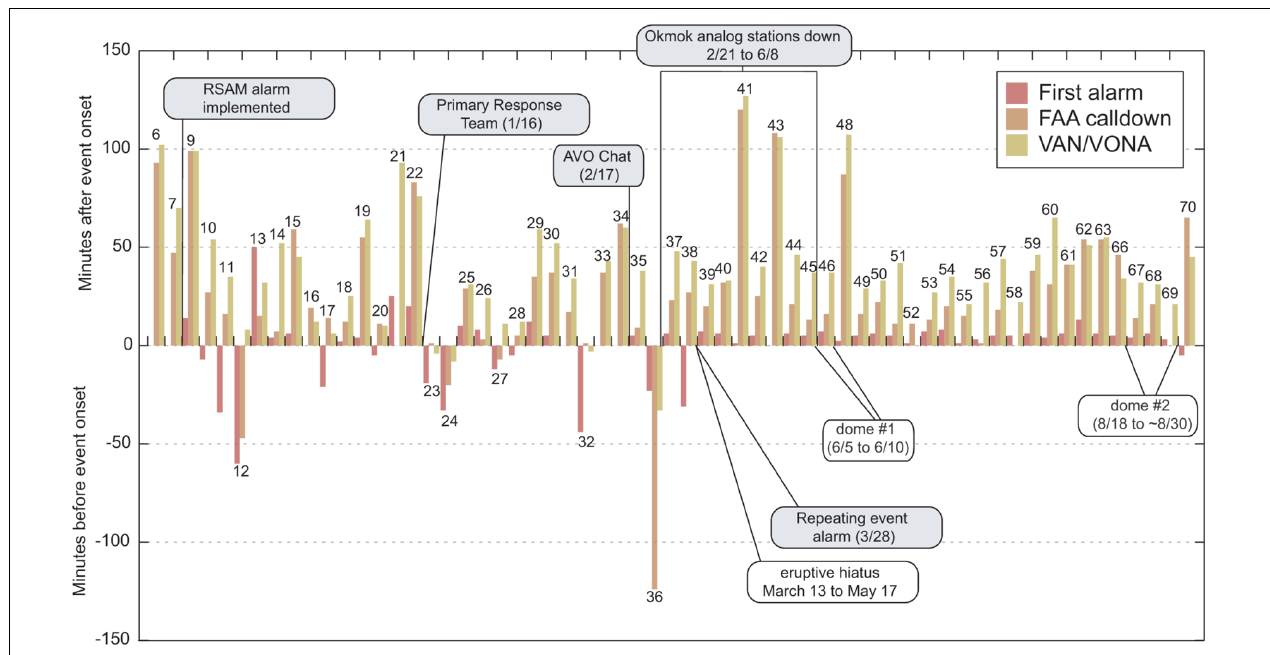
FIGURE 6 | Bar plot showing latency, in minutes, between explosive event onset and first alarm received, call to FAA, and release of first Volcanic Activity Notice. Numbers indicate numbered events, in chronological order. Gray labels indicate operational milestones, and white labels describe significant events in the eruptive sequence. Events for which neither call-downs nor written notifications were issued are not shown (for complete list of events, see Table 1